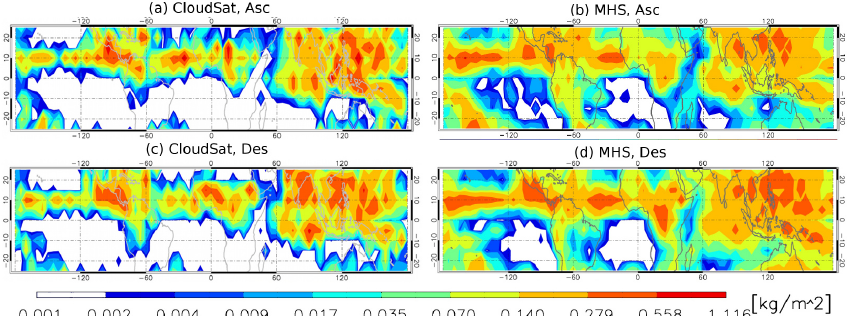
Figure 8. Monthly averaged IWP from CloudSat and MHS ascending (a, b) and descending (c, d) orbits during August 2010. MHS IWP is averaged over all views. Data are sampled to 5 ◦ × 5 ◦ grid boxes.